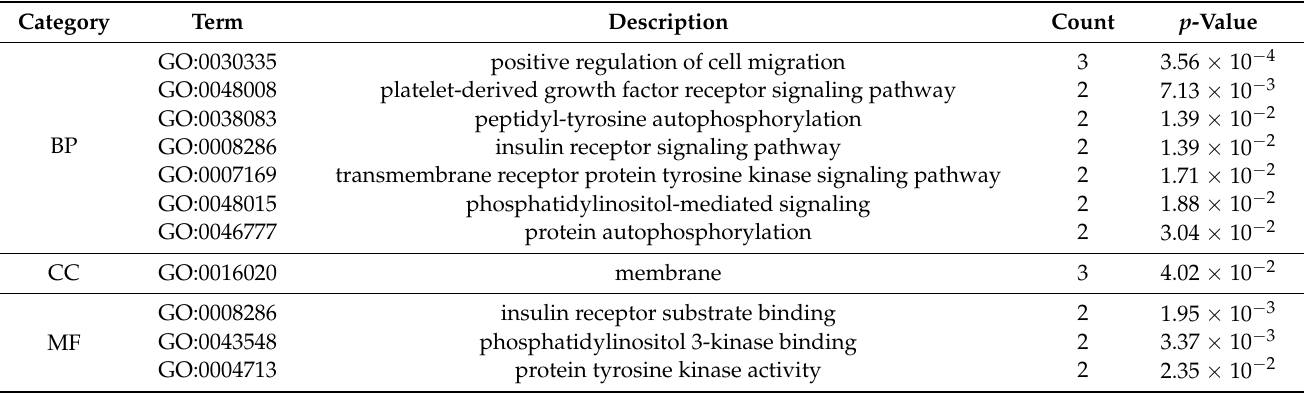
Table 1. The GO enrichment analyses of differentially expressed genes between TAD and Control.